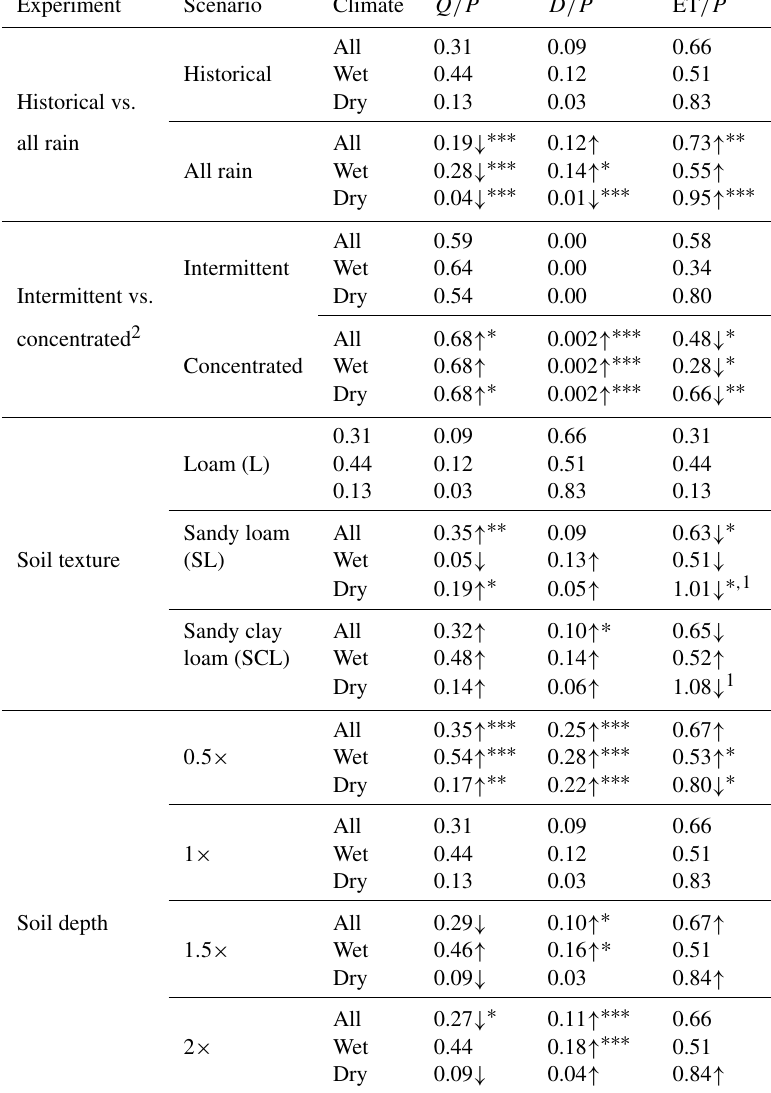
Table 3. Mean values of unitless response variables Q/P , D/P , and ET /P compared by climate type for four hypothetical scenarios: (1) historical vs. all rain input, (2) intermittent vs. concentrated input, (3) historical input on sandy loam, sandy clay loam, and loam profiles, and (4) historical input on 0 . 5 × , 1 × , 1 . 5 × , and 2 × original rooting zone depth. Dry sites P/ PET ≤ 1, wet P/ PET > 1. All scenarios in the table besides those explicitly altering soil texture use the loam profile (1056). Asterisks denote the significance of ANOVA tests between groupings of simulations and arrows show the direction of change relative to the base scenario: historical input on 1 × depth profile with loam texture. P value of ANOVA, ∗ < 0 . 5, ∗∗ < 0 . 01, ∗∗∗ < 0 . 001. Boxplots correspond to values in Table